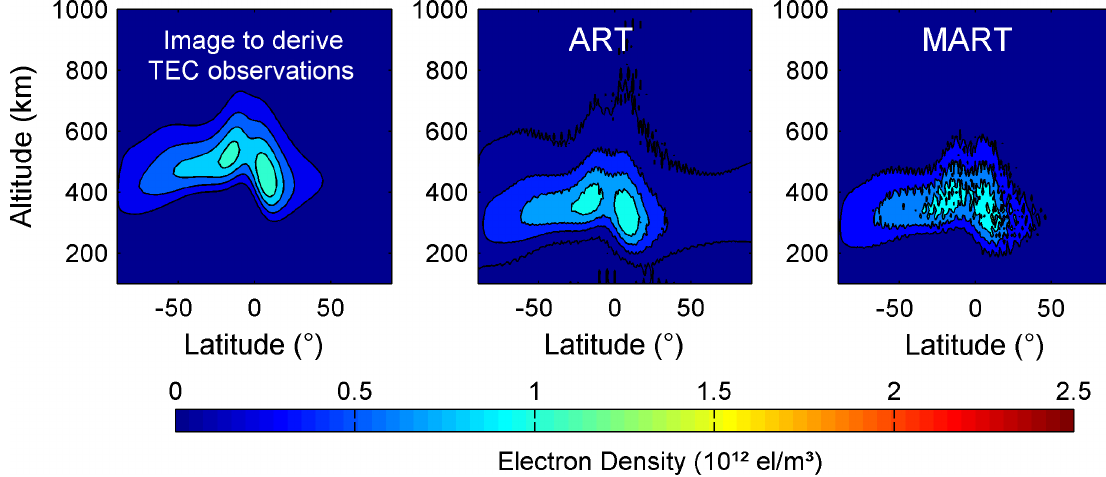
Figure 5 - 2D algebraic technique performance in Case III (height